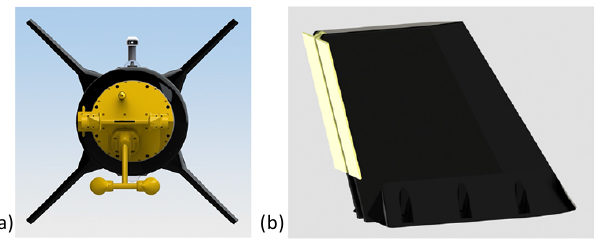
Figure 3. (a) Front view of the AIRTOSS showing the asymmetri- cal shape of the CCP instrument. (b) Air brake at one wing of the AIRTOSS (Röschenthaler,